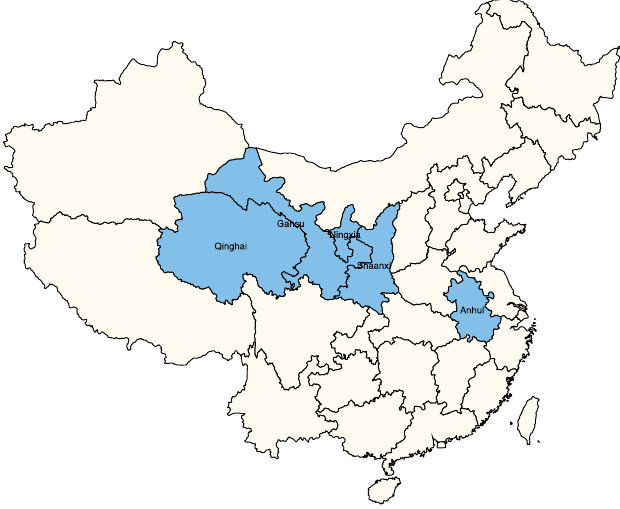
Figure 1. Location of the five sample provinces in China.